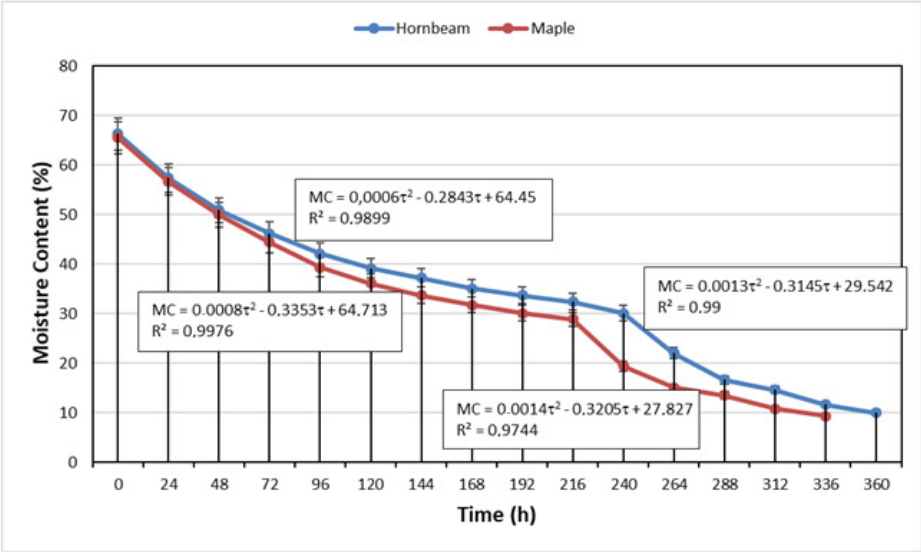
Figure 1. Drying curves for hot-air drying mode (60 °C).